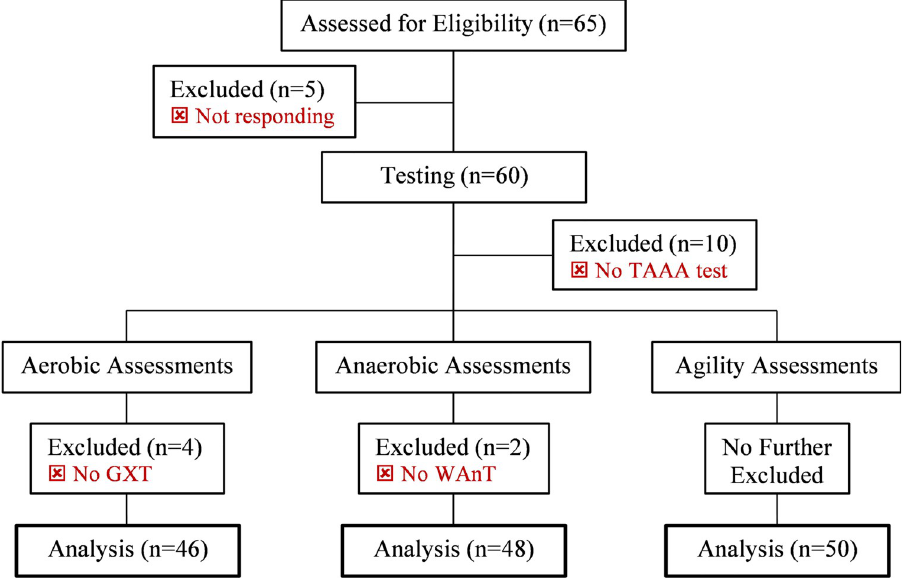
Fig 1. Flow chart of study progress. TAAA: Taekwondo-specific aerobic-anaerobic-agility test; GXT: Graded exercise test; WAnT: Wingate anaerobic test.